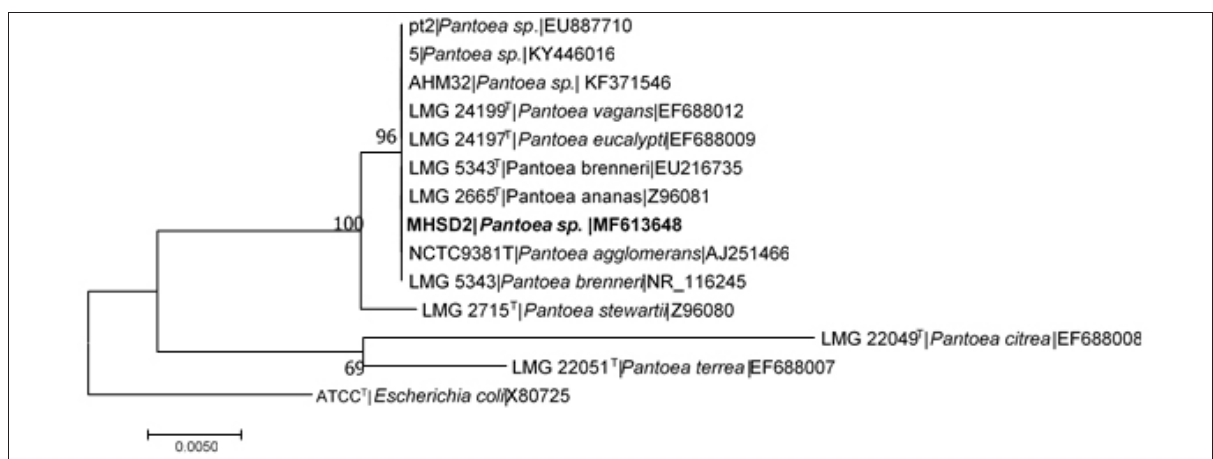
Figure 2: Maximum likelihood tree based on the 16S rRNA gene sequences of Pantoea sp. MHSD2 and its closest phylogenetic neighbours. The numbers on nodes indicate bootstrap values after 1000 replicates expressed in percentages. Escherichia coli strain ATCC X80725 was included as an outgroup. T indicates type strains.